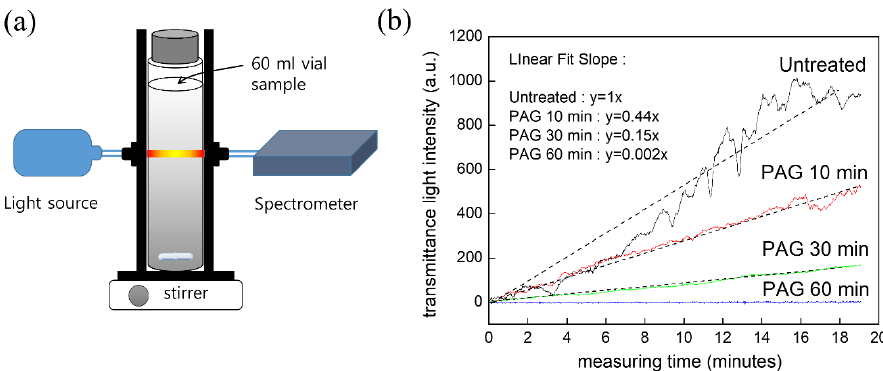
Figure 5. Quantitative evaluation of the dispersion by measuring transmittance light intensity. ( a ) Experimental setup for light intensity measurement, and ( b ) comparison of light intensity measurement at several PAG treatment times of 10, 30, and 60 min.